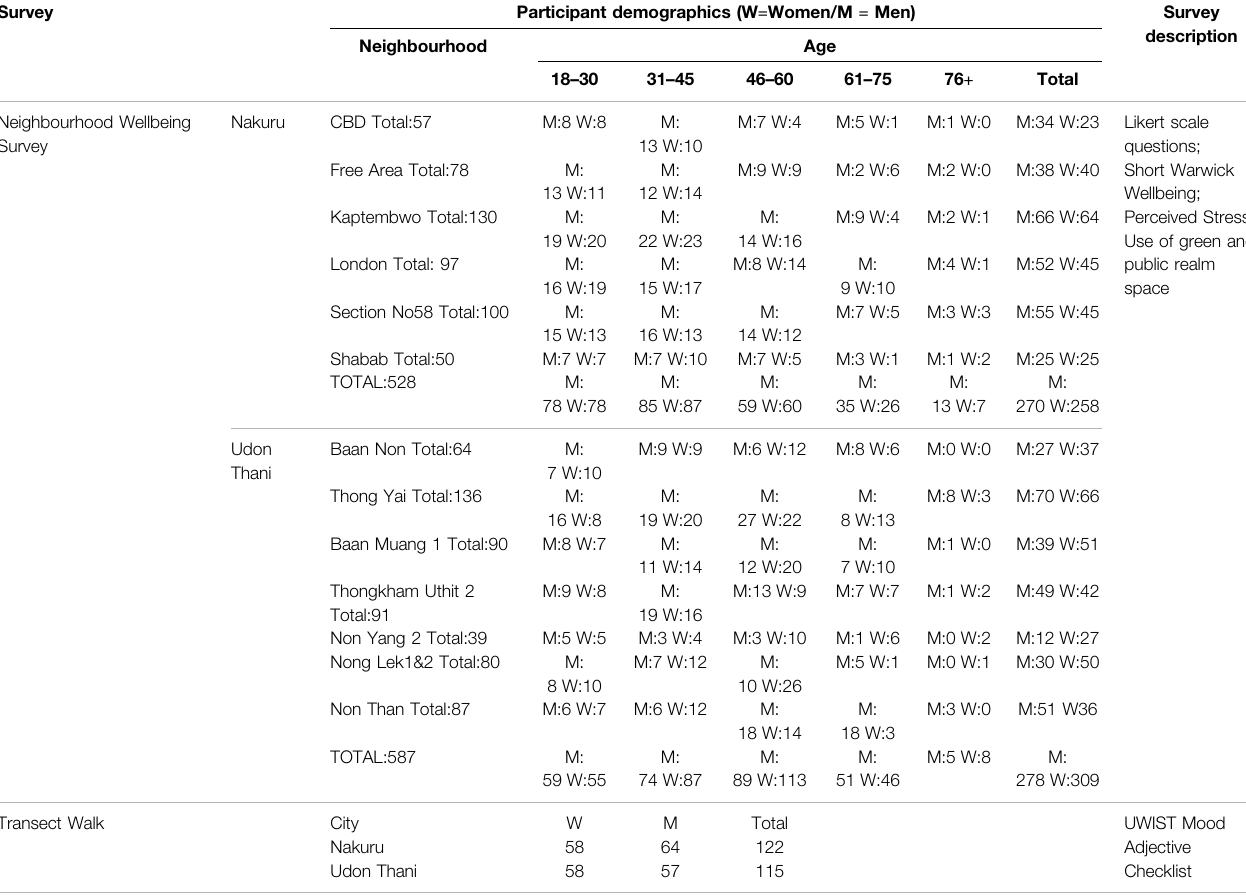
TABLE 1 | Survey participant demographics (Note: Thailand median age 40.1 yrs vs Udon Thani Neighbourhood wellbeing survey median age 46.26 years; Kenya median age20.1 yearvsNakuruNeighbourhoodwellbeingsurveymedianage41.96 years(countrydemographicinformationfromworldometers.infoSep2021).Themeanage of the UWIST surveys was in Nakuru, 22.8 years for women, 24.6 years for men; Udon Thani, 24.1 year for women; 24.7 years for men) .